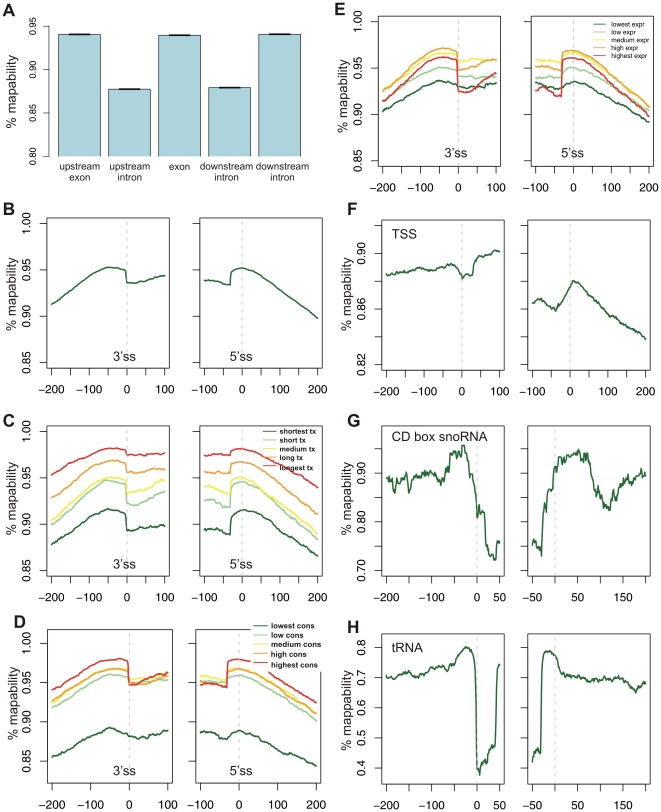
Mappability within genomic regions.(A) Mean mappability density values within internal exons and within the exons and introns flanking them. Error bars represent the standard error of the mean (SEM). (B) Mappability in the region surrounding exon/intron junction. The dashed line represents the exon/intron junction. (C) Mappability in the region surrounding exon/intron junction as a function of total transcript length. Each exon was distributed into one of five bins based on the length of the transcript containing it. (D) Mappability in the region surrounding exon/intron junction as a function of exon conservation level, divided into five bins. (E) Mappability in the region surrounding exon/intron junction as a function of transcript expression level, divided into five bins. Transcript expression levels were obtained from [27]. (F) Mappability in the regions surrounding transcription start and end sites. (G) Mappability in the regions surrounding CD box snoRNA start and end sites. (H) Mappability in the regions surrounding tRNA start and end sites.